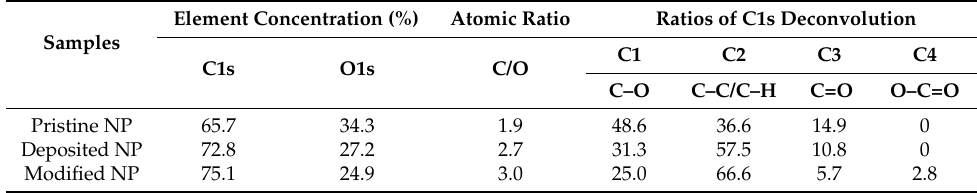
Figure 4. XPS spectra of pristine, deposited and modified NP samples: ( a ) survey spectra and ( b ) deconvolution of the C1s spectra. Table 1. Assignment of the XPS C1s peaks.